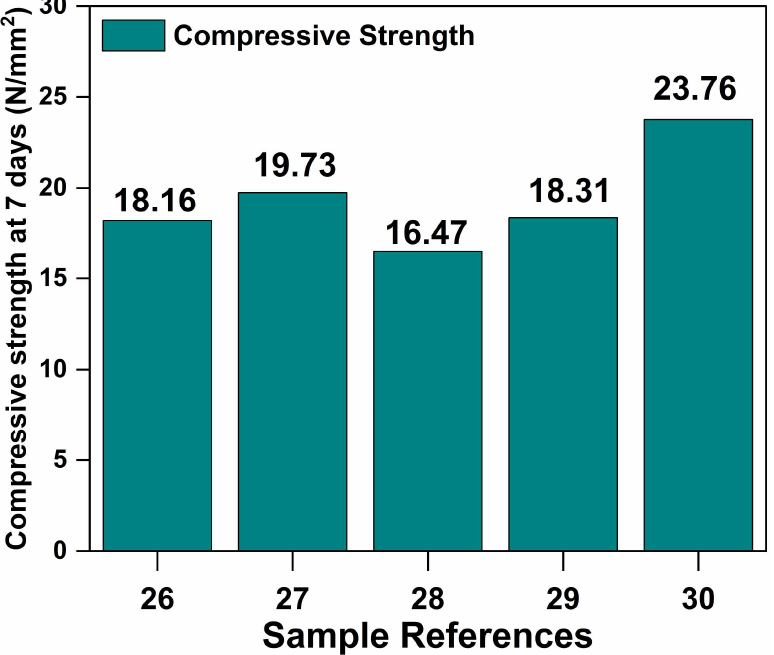
Figure 3. Compressive strength at 7 days of curing age—Stage 3.